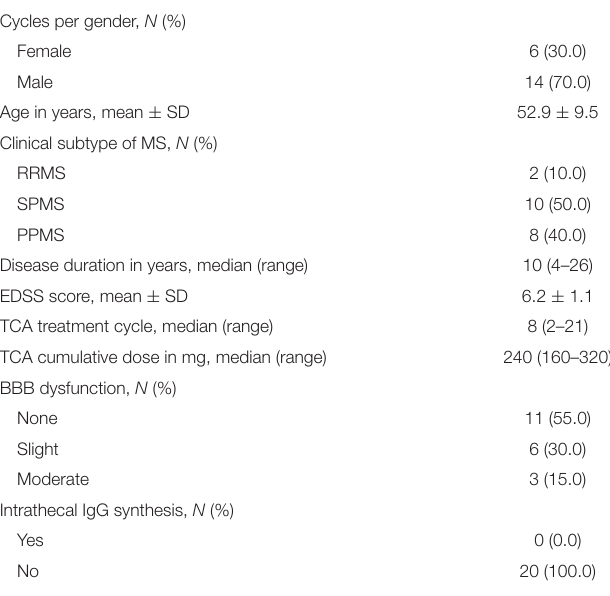
TABLE 1 | Clinicodemographic and pharmacological